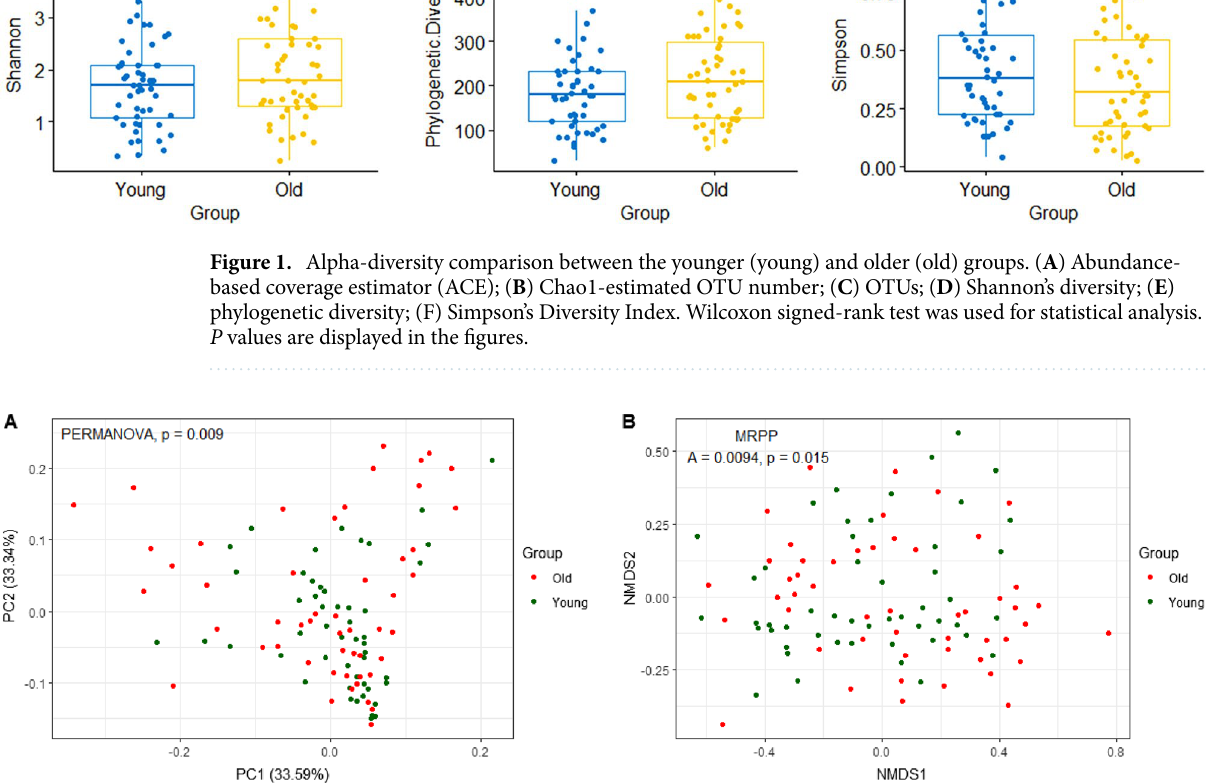
In addition, differences in the distribution of skin microorganisms according to gender were confirmed at the phylum level, family level, and species level. There were no significant differences in the four major skin phyla (Supplementary Fig. 4). Figure 5 indicates the relative abundance of the four dominant families between the male and female groups. Staphylococcaceae and Corynebacteriaceae showed a high distribution in the male group; Lactobacillaceae, which belongs to the lactic acid bacteria family, showed a higher relative abundance in the female group. The difference in distribution at the family level was similar to the genus level; Staphylococcus and Corynebacterium were significantly higher in the male group and Lactobacillus was significantly higher in the female group (Fig. 6). The linear discriminant analysis (LDA) model identifies differently abundant taxa between groups and esti- mates each significantly different taxon’s effect size 22,23 . We evaluated the LDA effect size (LEfSe) among groups in the younger group, and Enhydrobacter was the most abundant in the older group. Additionally, we analyzed